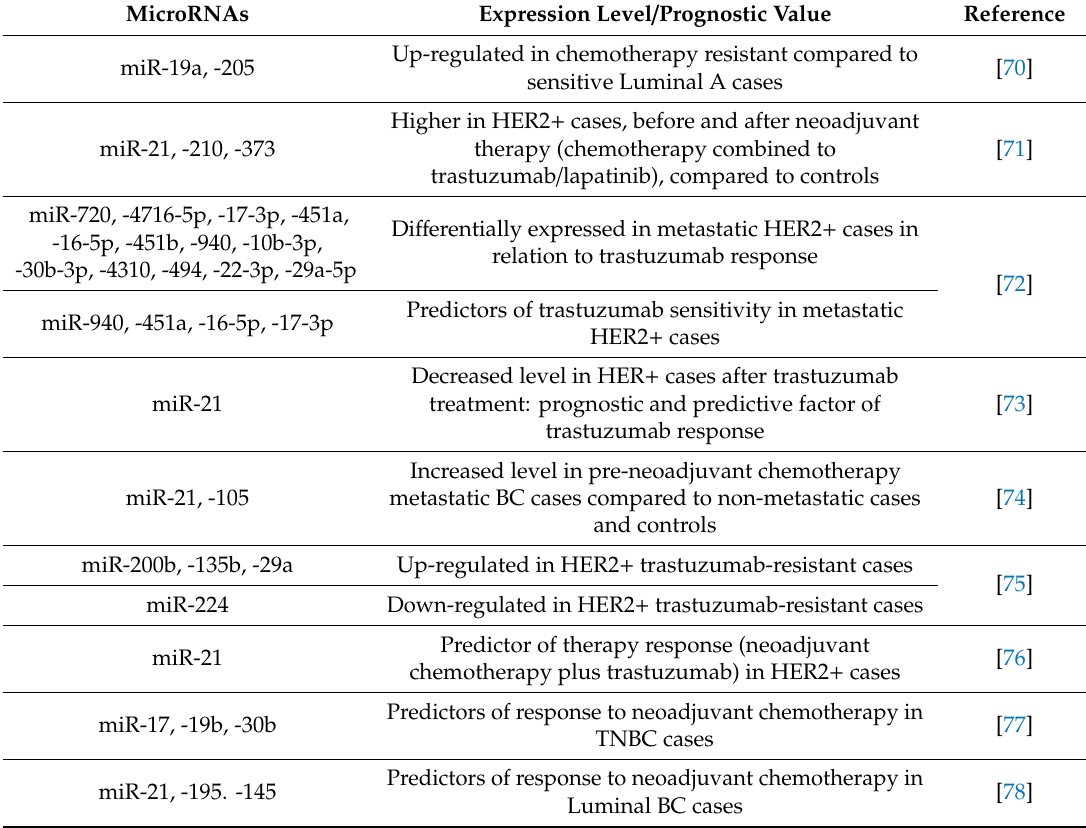
Table 2. Role of circulating microRNAs in response to therapies of breast cancer